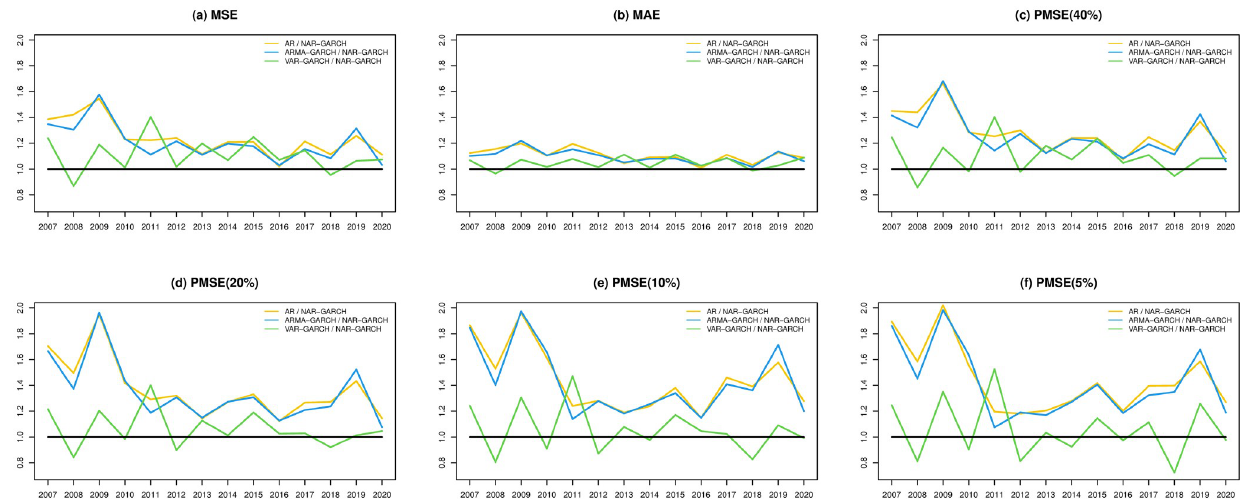
Fig 6. The prediction performances of the 4 models for the N225